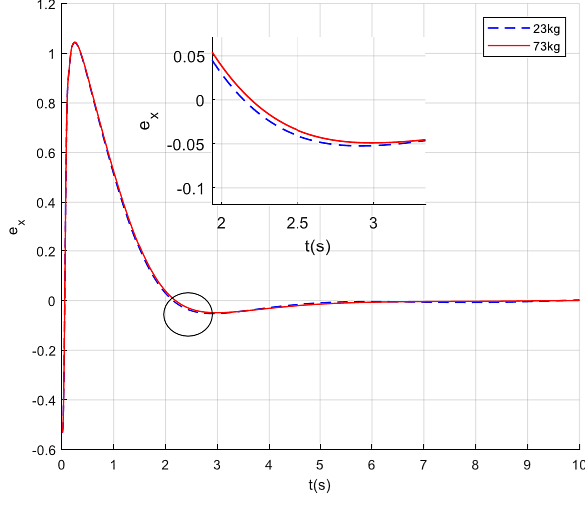
Figure 5. Result of linear velocity ( a ) and angular velocity ( b ) in tracking circular trajectory under varying loads.